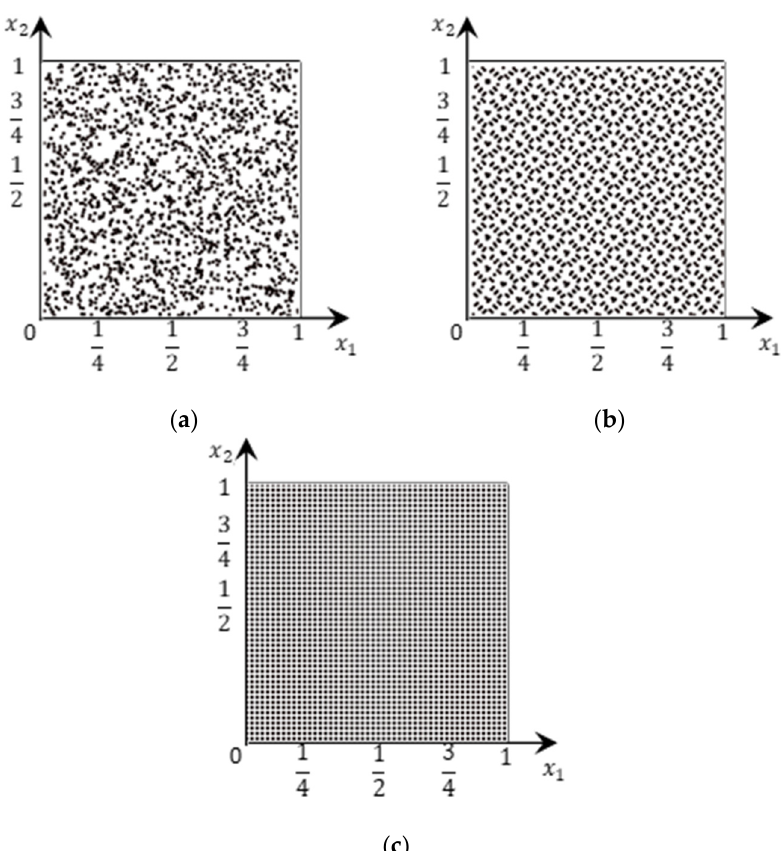
Figure 4. ( a ) is the distribution map for the direct generation algorithm, ( b ) is the distribution map for the Sobol sequence algorithm, and ( c ) is the distribution map for the global regular grid distribution algorithm.